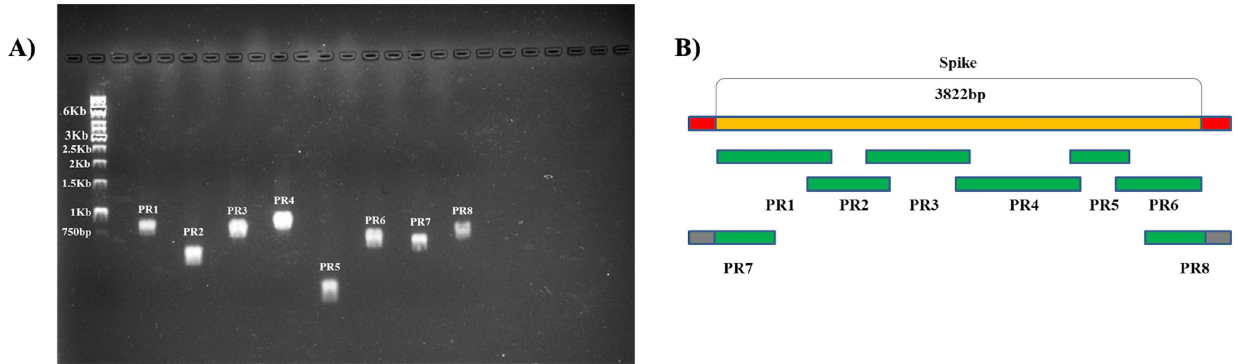
Fig 4. Agarose Gel Electrophoresis and schematic representation of the targeted fragments of each set of primers. Amplification of S gene is visualized in agarose Gel Electrophoresis (A). Schematic representation of the targeted fragments of each set of primers is shown in (B). PR1 represents primer set 1, PR2 primer set 2, PR3 primer set 3, PR4 primer set 4, PR5 primer set 5, PR6 primer set 6, PR7 primer set 7 and PR8 primer set